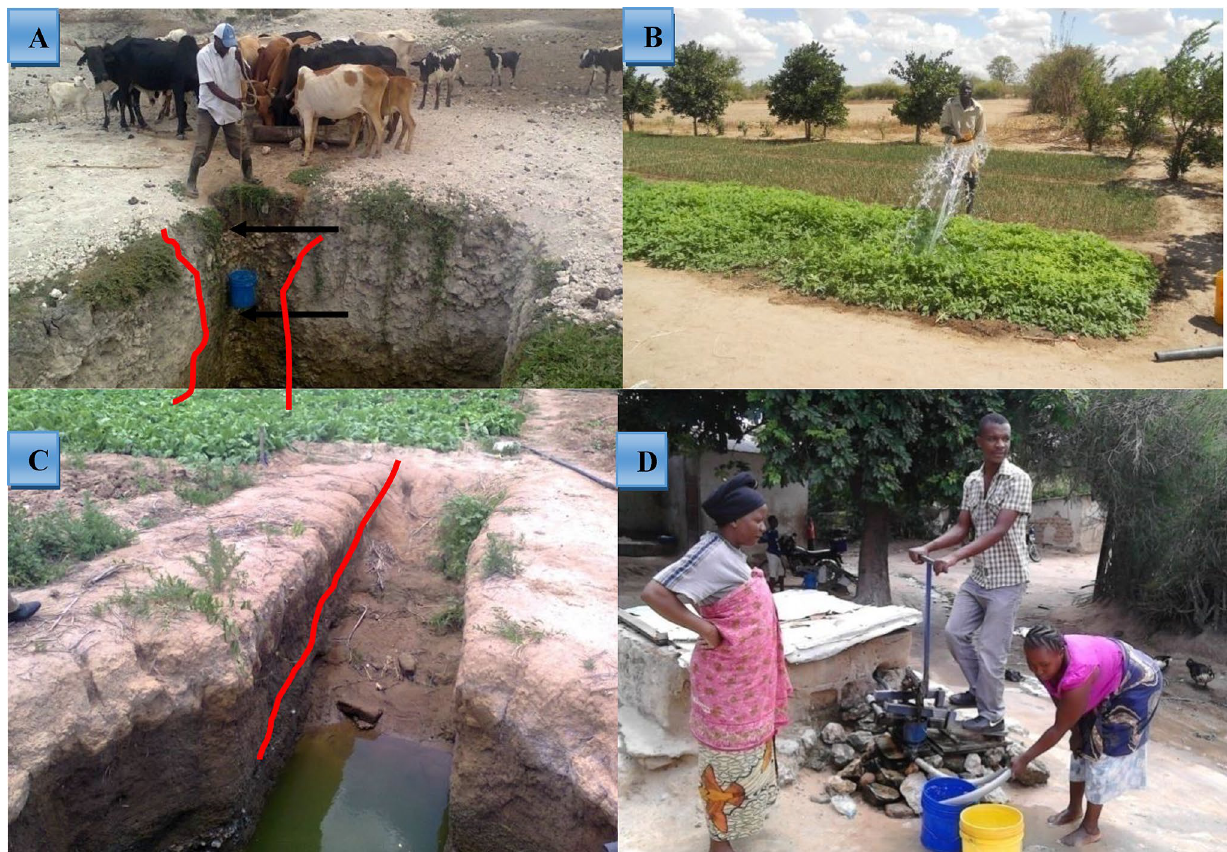
Fig. 1 Major SDWs uses, designs, types of water abstractions